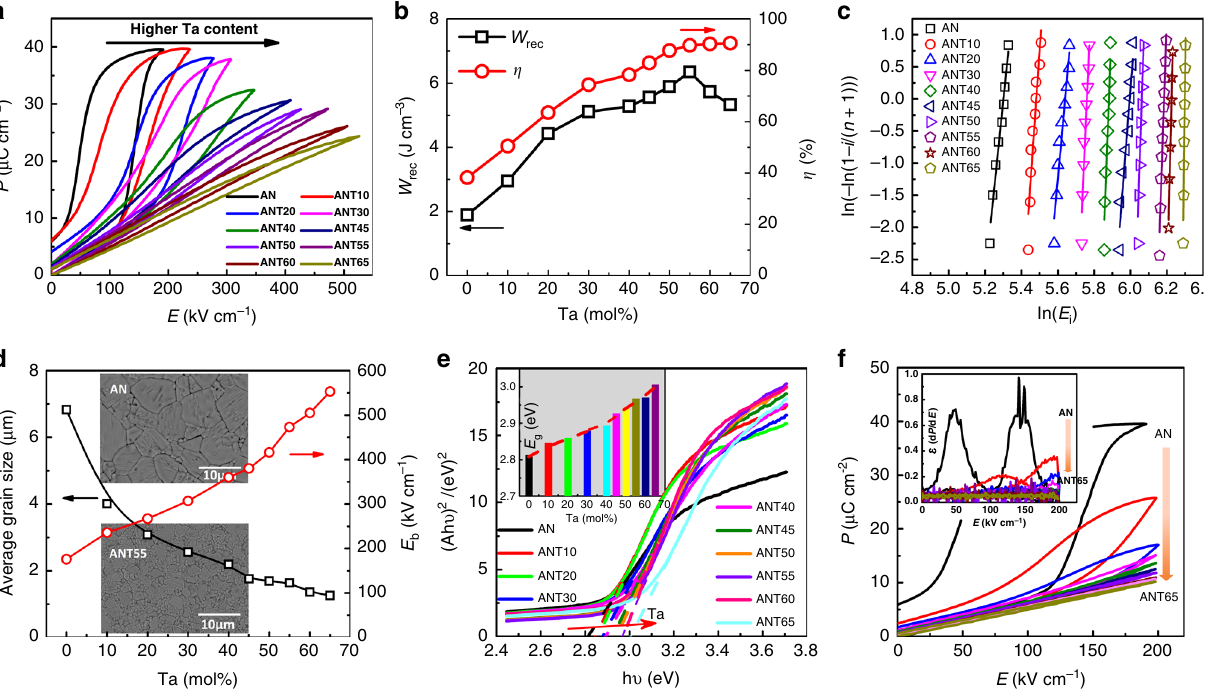
Fig. 3 Ferroelectric and energy storage performance of ANT x ceramics, and their breakdown analysis. a The P – E loops. b Composition-dependent energy storage properties ( W rec and η ). c Weibull distribution of the breakdown electric fi eld E b on samples with thickness of ~0.15 mm. d The composition dependence of average grain size and E b , the insets give the SEM micrographs of the AN and ANT55 ceramics, respectively. e UV – vis absorption spectra of AN and ANT x . The inset is the composition-dependent band gap E g . f The composition-dependent polarizations (AN:190 kV cm − 1 ; others:200 kV cm − 1 ), the inset gives the fi eld dependent dielectric permittivity ( ε = d P /d E